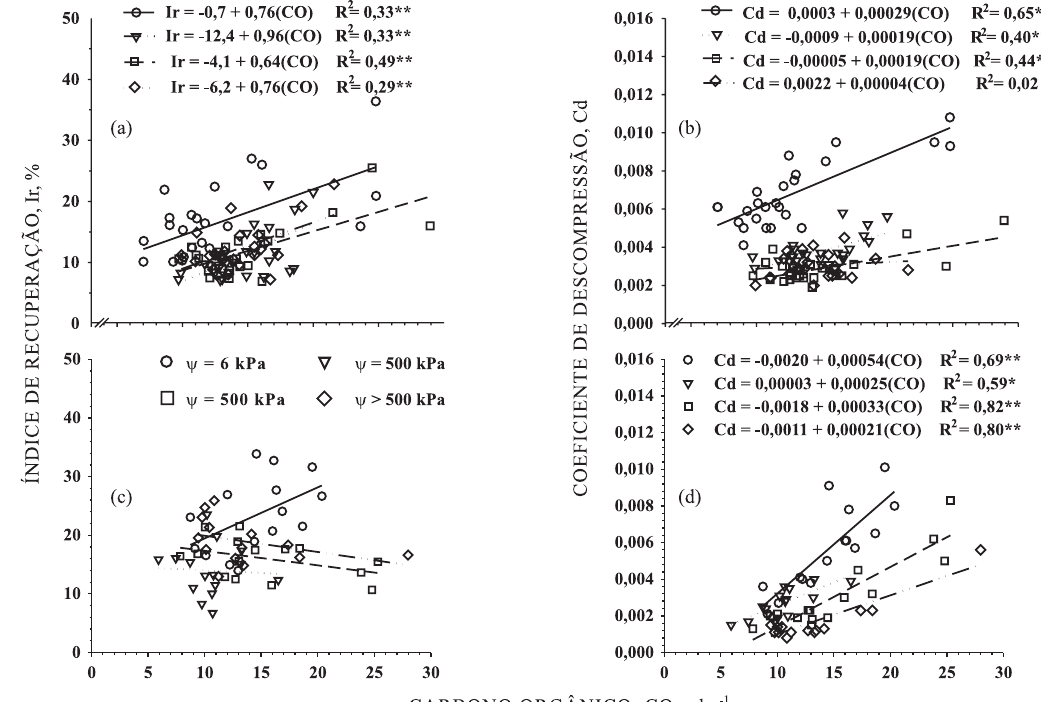
4. Índice de recuperação e coeficiente de descompressão em função do teor de carbono orgânico de um Nitossolo Vermelho distrófico latossólico (a) e (b), respectivamente, e de um Argissolo Vermelho- Amarelo distrófico arênico (c) e (d), respectivamente, submetidos a quatro tensões de água ( ψψψψψ